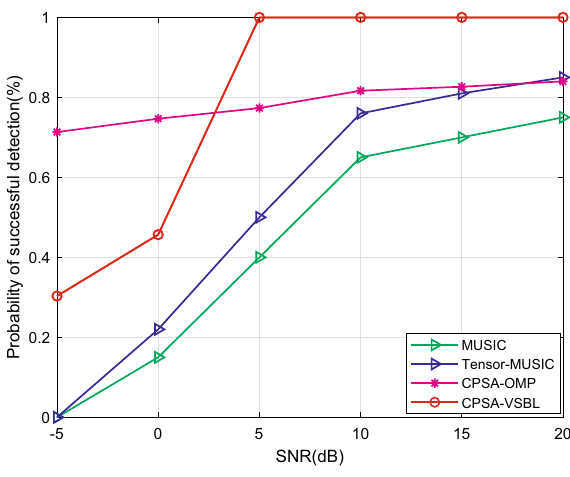
Fig. 9 The probability of successful detection versus